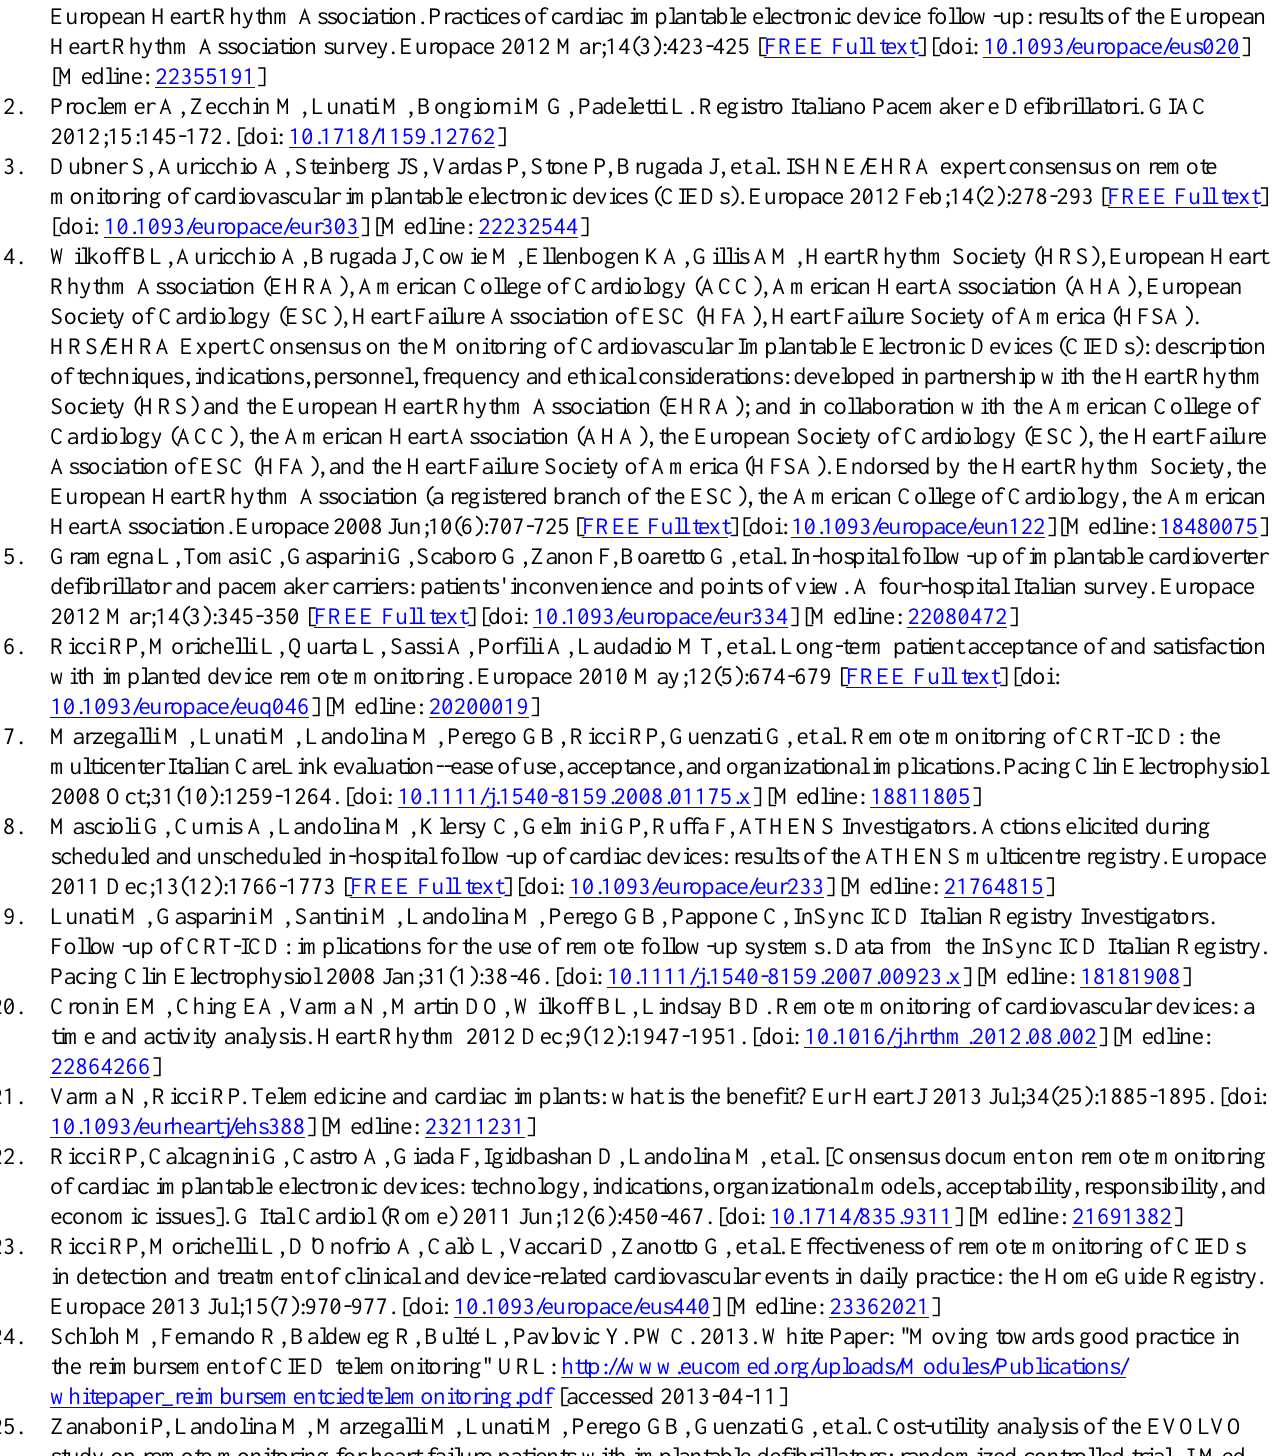
CRT-D: cardiac resynchronization therapy ICD EHRA: European Heart Rhythm Association ICD: implantable cardioverter defibrillator RM: remote